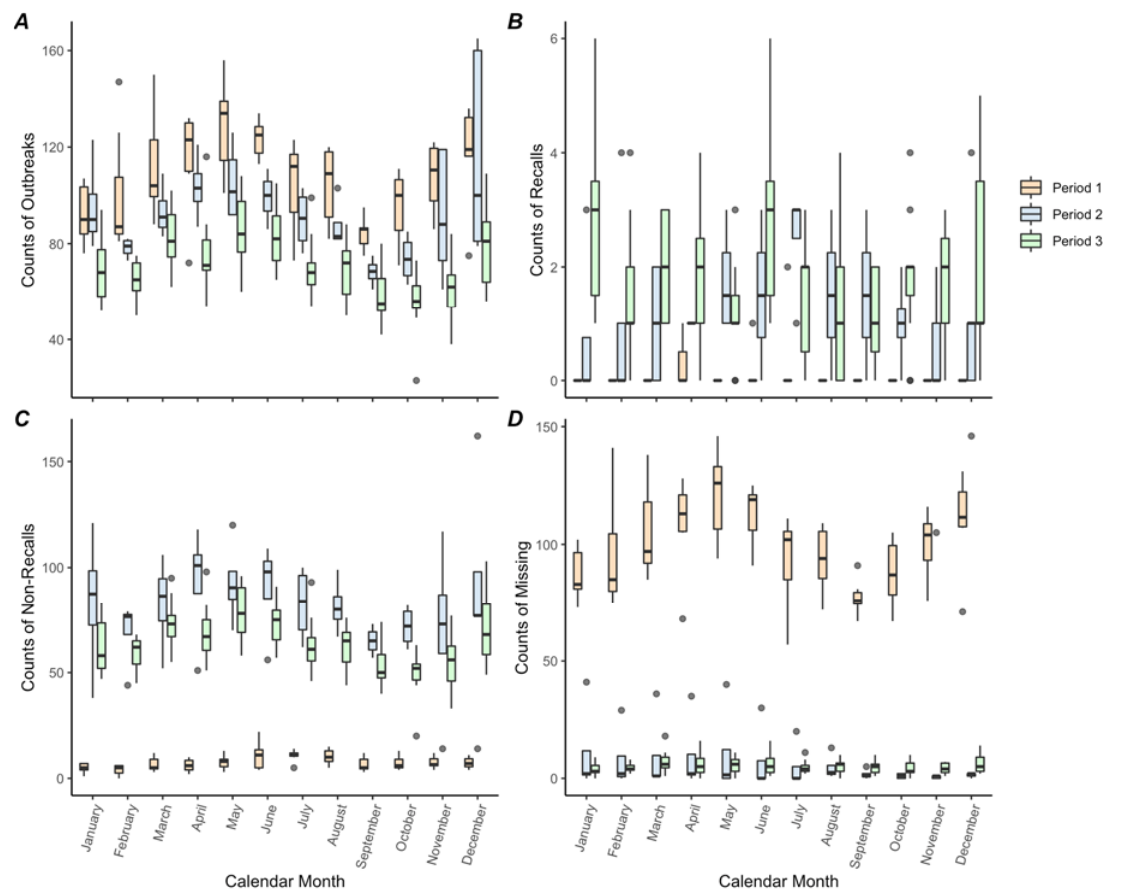
Figure 2. Boxplots of monthly counts of outbreaks ( A ), recalls ( B ), non ‐ recalls ( C ), and outbreaks missing recall information ( D ), as reported by the electronic Foodborne Outbreak Reporting System (eFORS) and National Outbreak Reporting System (NORS) in 1998–2019. Each of the 3 critical periods is indicated by using a different box color. Grey dots represent outliers.